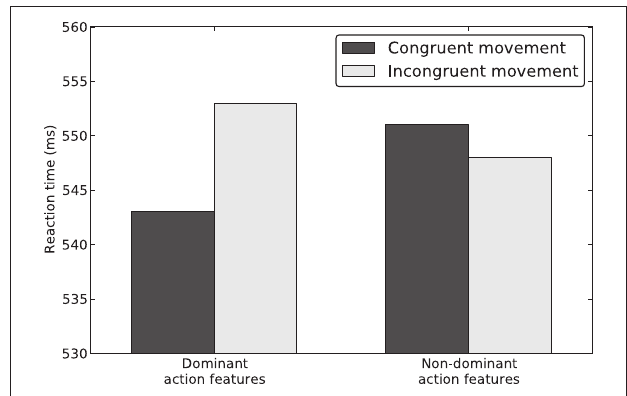
Figure 2 | Average reaction times (rTs) for words, as a function of the congruency between the cue and associated movement direction, and the contextual focus (focus on dominant action feature vs. non-dominant action feature) .